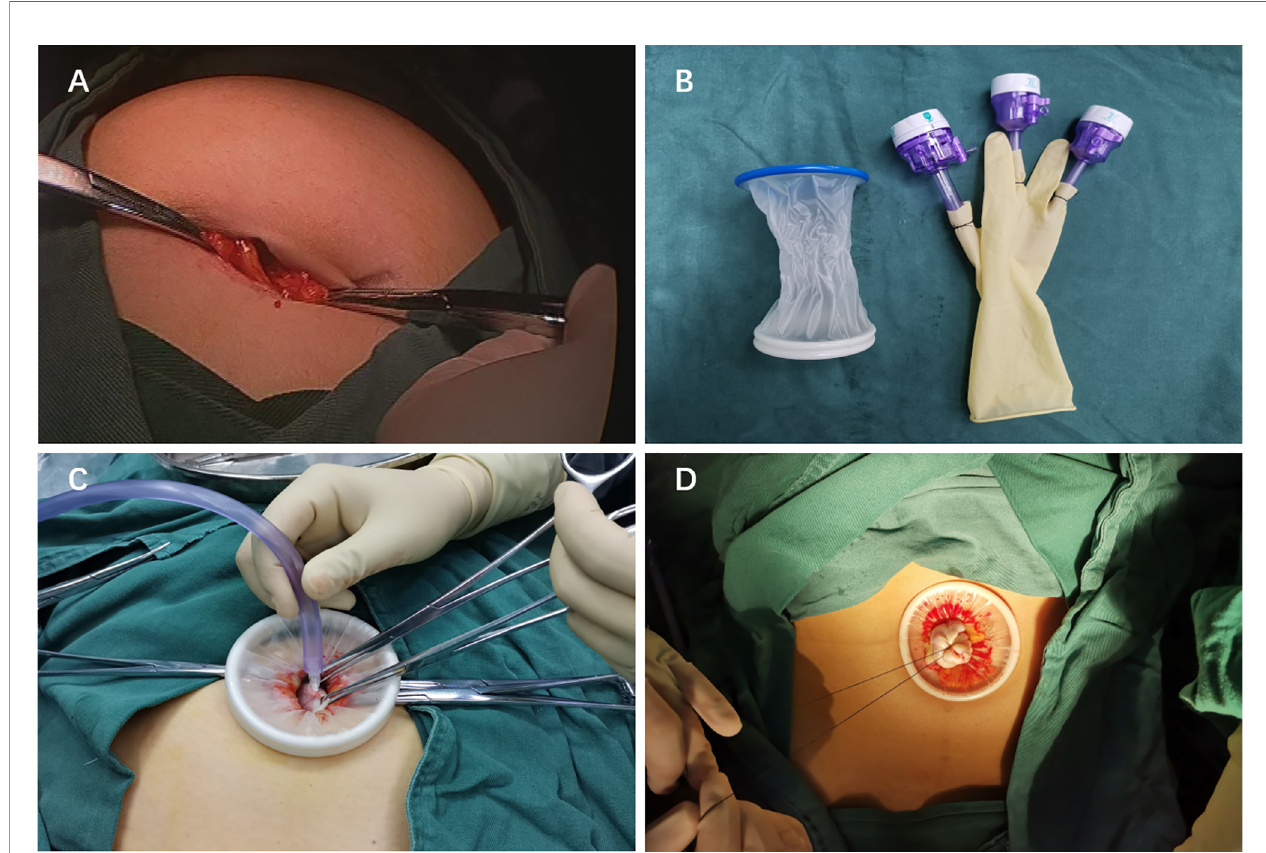
( Figure 3F ). The average operative time was 85.2 min (range 37 – 132 min). Neither extravasation of cystic fl uid and